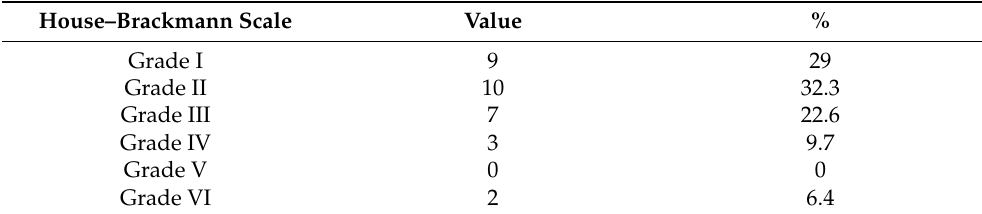
Table 3. Post-operative facial